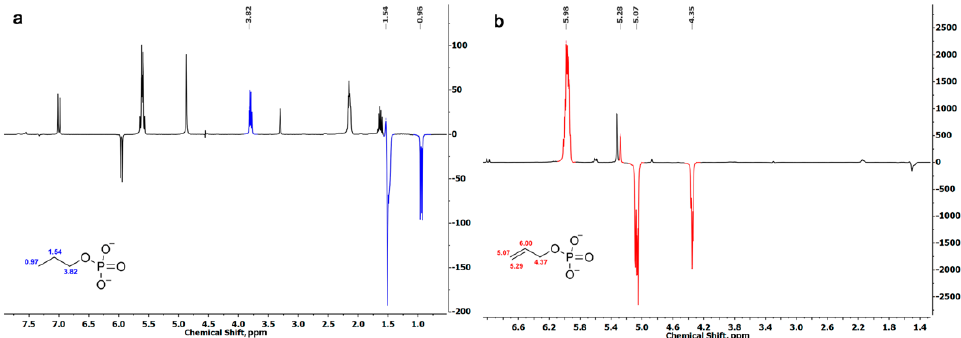
Figure 2. Shows 1 H NMR ALTADENA spectra obtained by hydrogenation of cyclohexylamine allyl phosphate 2 ( a ) and cyclohexylamine propargyl phosphate 1 ( b